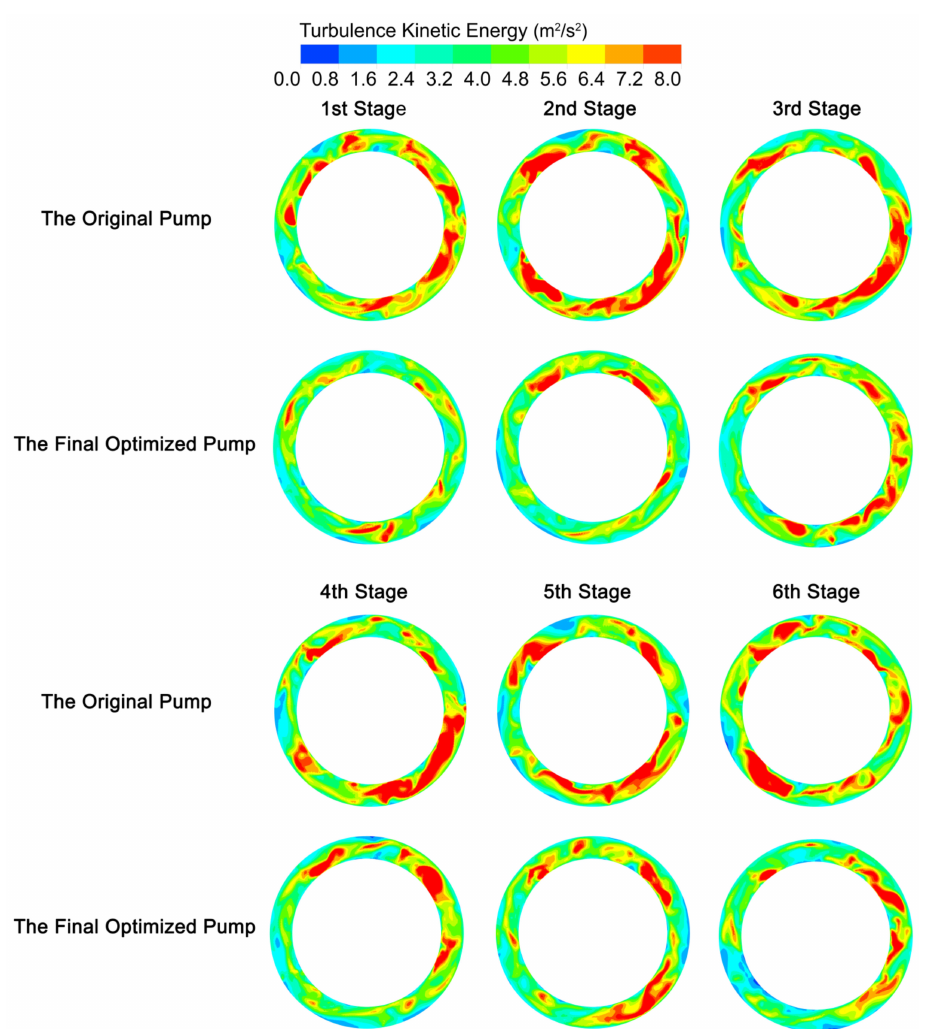
Figure 15. The turbulence kinetic energy on the cross-section at the transition between the impeller outlet and the diffuser inlet.